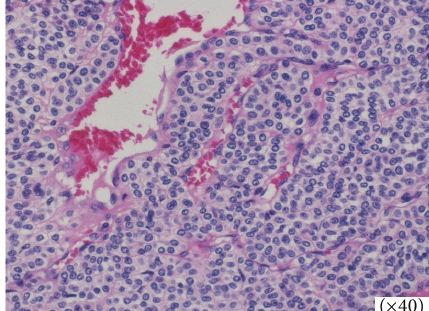
Figure 3: Histological findings. Microscopic examination shows numerous dilated, thin-walled vascular spaces surrounded by uni- form glomus cells (hematoxylin and eosin staining; magnification, × 40).